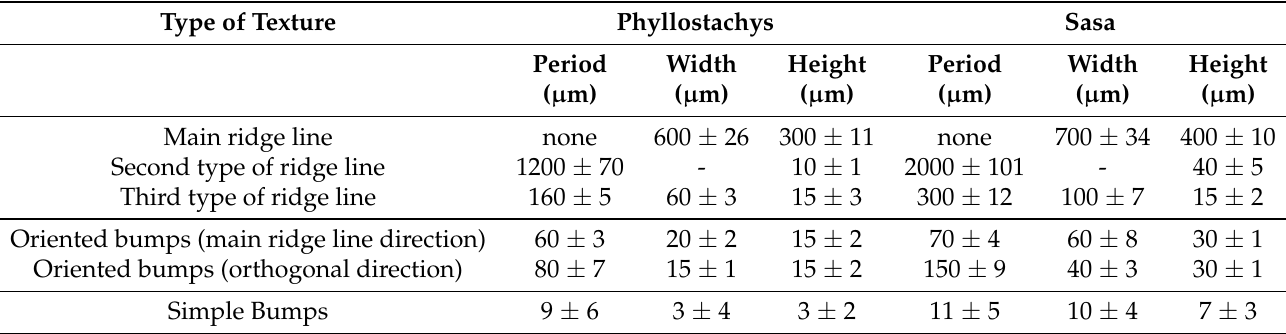
Table 1. Summary of the different textures on the surface of bamboo leaves.